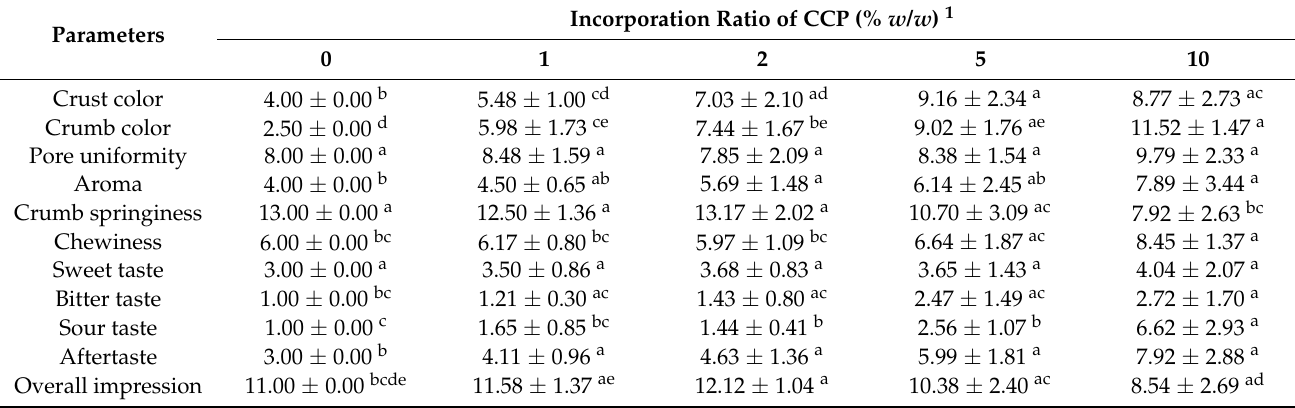
Table 5. Sensory analysis of the experimental bread